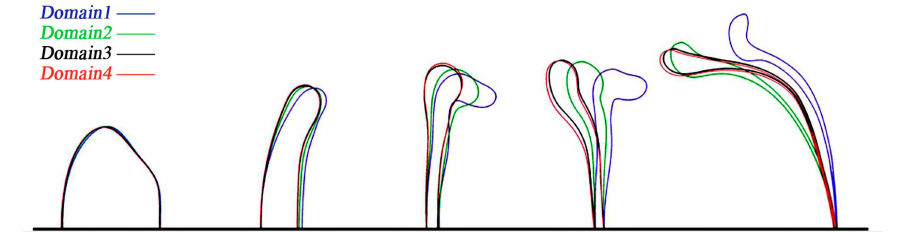
Figure 2. The evolutions of droplet morphology for various domain sizes.